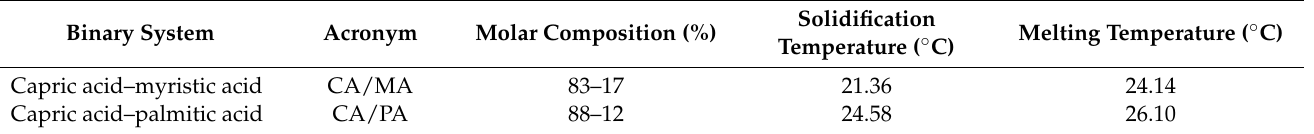
Table 3. Fatty acids eutectic mixtures